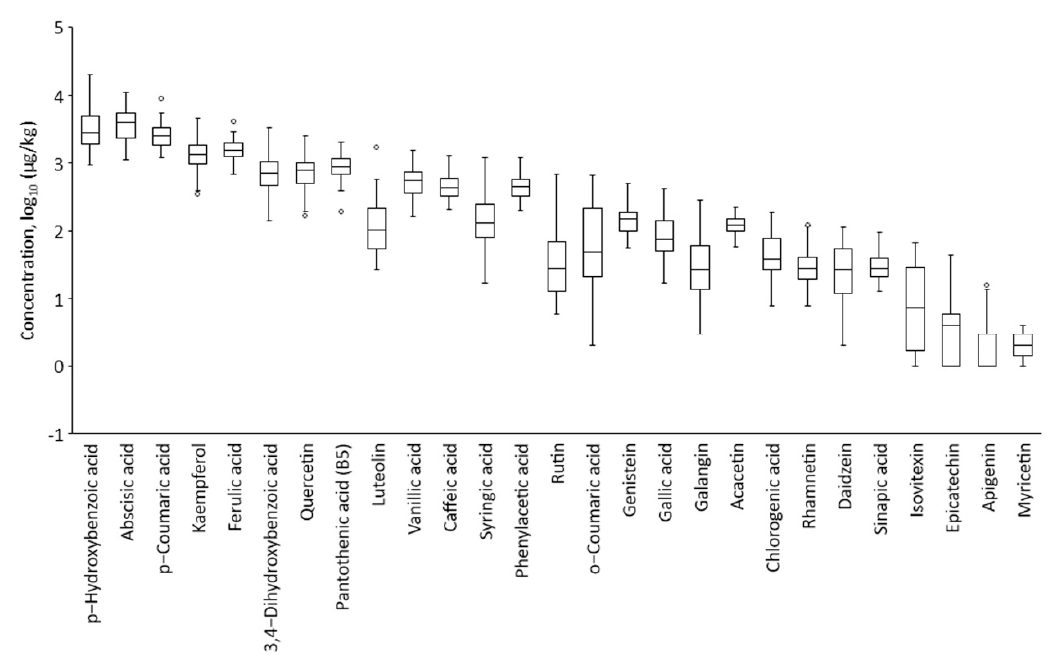
Figure 1. Boxplots of organic compound concentration ( μ g/kg) in polyfloral honey determined by UHPLC-HRMS; results converted in decimal logarithm scale.